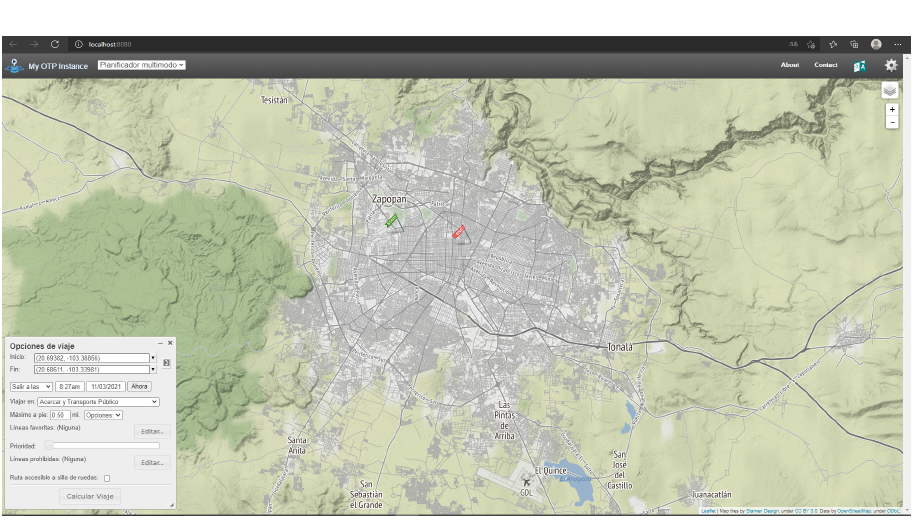
Table 1. Data generated by a request in